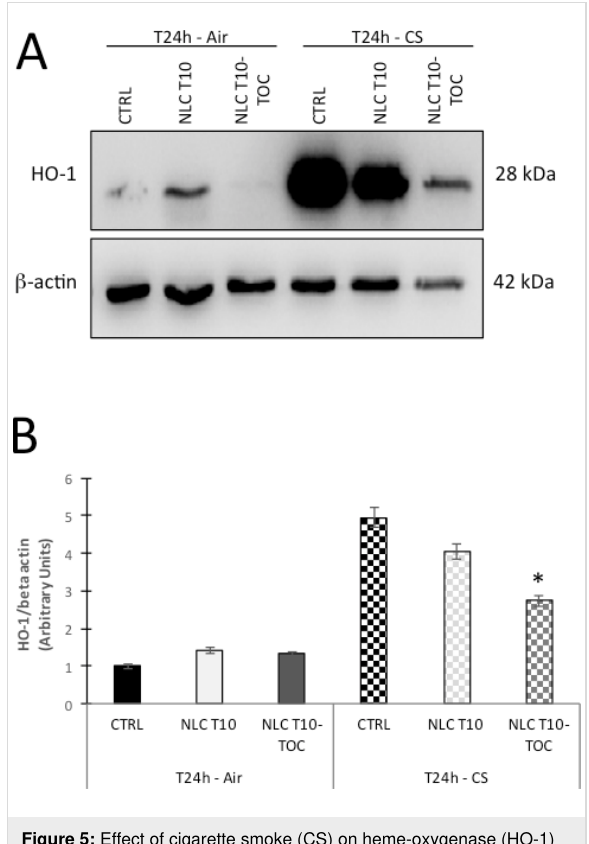
Figure 5: Effect of cigarette smoke (CS) on heme-oxygenase (HO-1) expression evaluated on human skin explants (HSE) treated with NLCT 10 or NLCT 10-TOC, exposed to air or CS for 30 min and harvested after 24 h. A) Representative Western blot analyses of HO-1 protein expression (with the respective β -actin controls). B) Mean expression of HO-1 as a ratio of β -actin. The results are shown as the mean of three experiments. * p < 0.05 with respect to the